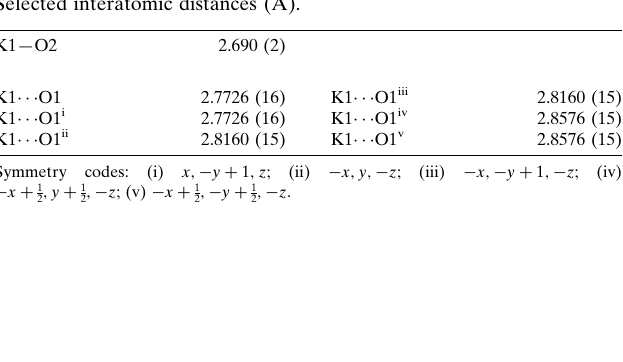
Selected interatomic distances (A˚